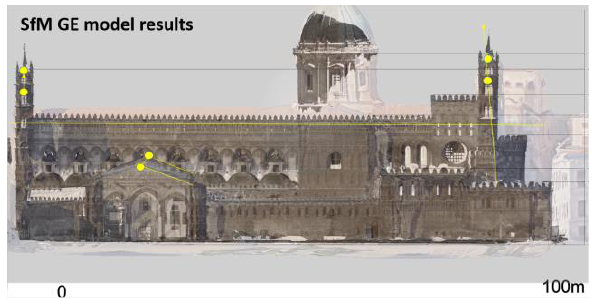
Figure 15. The aligned model